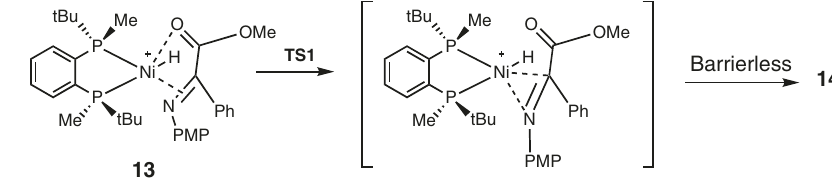
Fig. 5 Intrinsic mechanism of the hydride transfer. The con fi guration with coplanar orientation of Ni – C and Ni – H